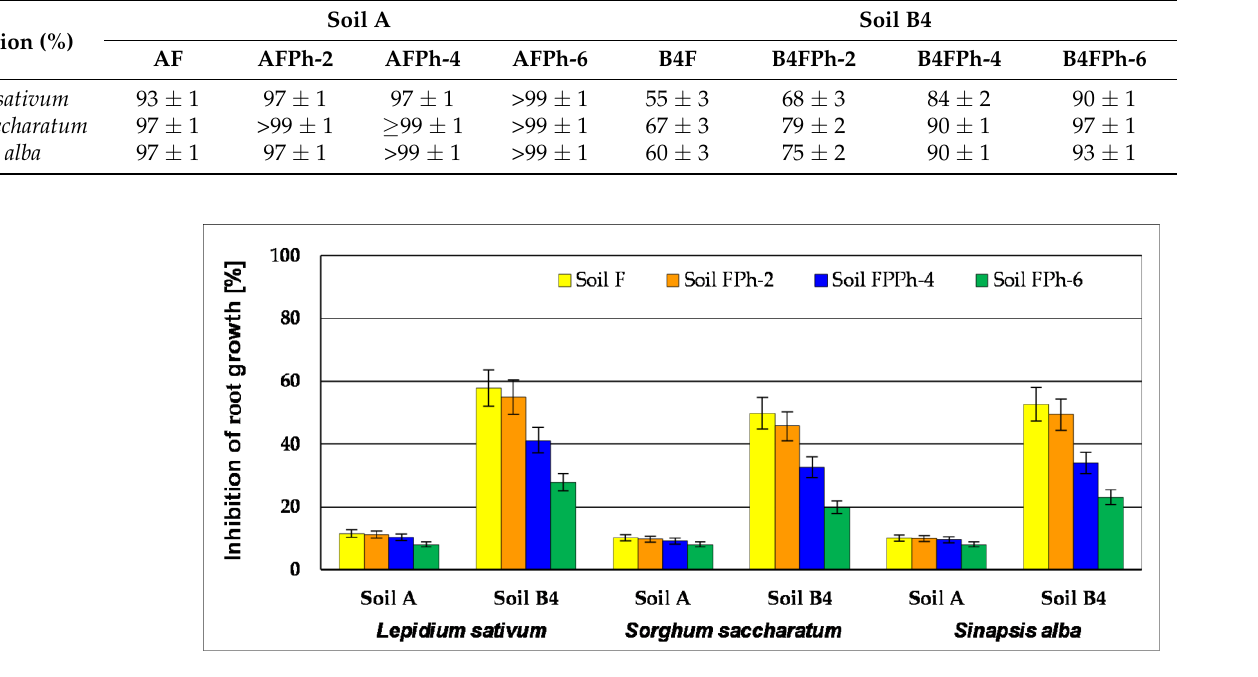
Figure 8. Comparison of root growth inhibition ( Lepidium sativum , Sinapis alba , Sorghum saccharatum ) in the Phytotoxkit TM test during soil phytoremediation (repetitions number n = 3, p < 0.05).